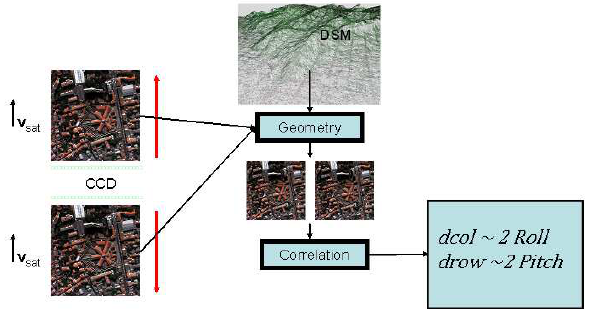
Figure 3: bias assessment using reverse